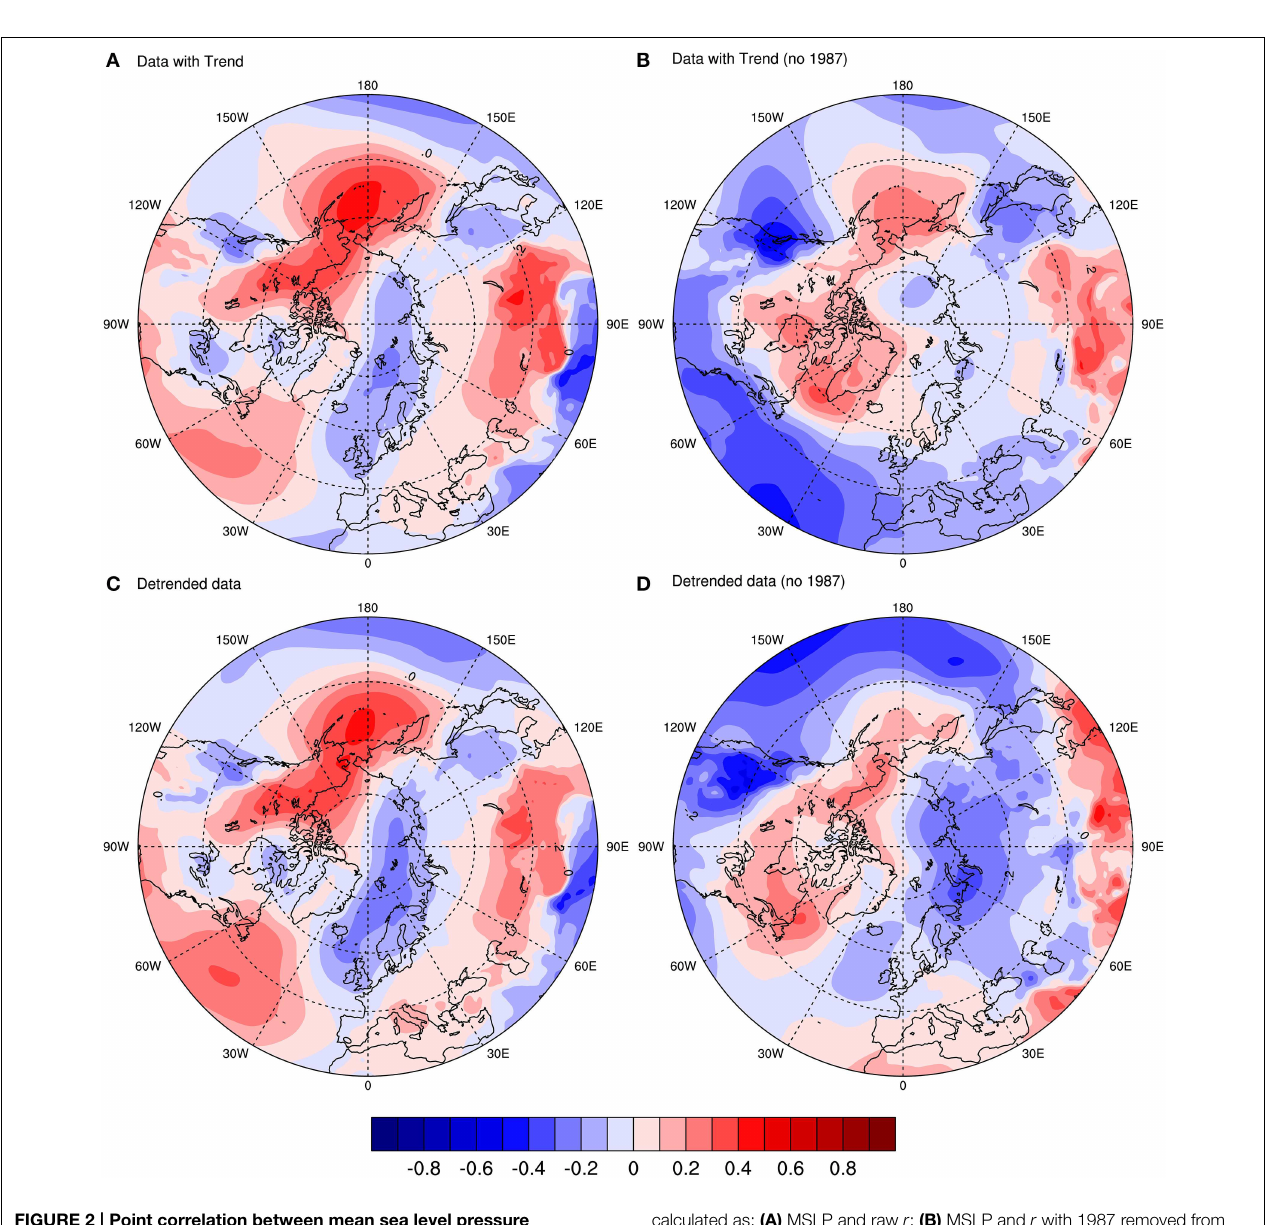
FIGURE 2 | Point correlation between mean sea level pressure (MSLP) and guillemot population growth rate ( r ) based on the period from 1980 to 2011. The four plots display the correlation coefficient